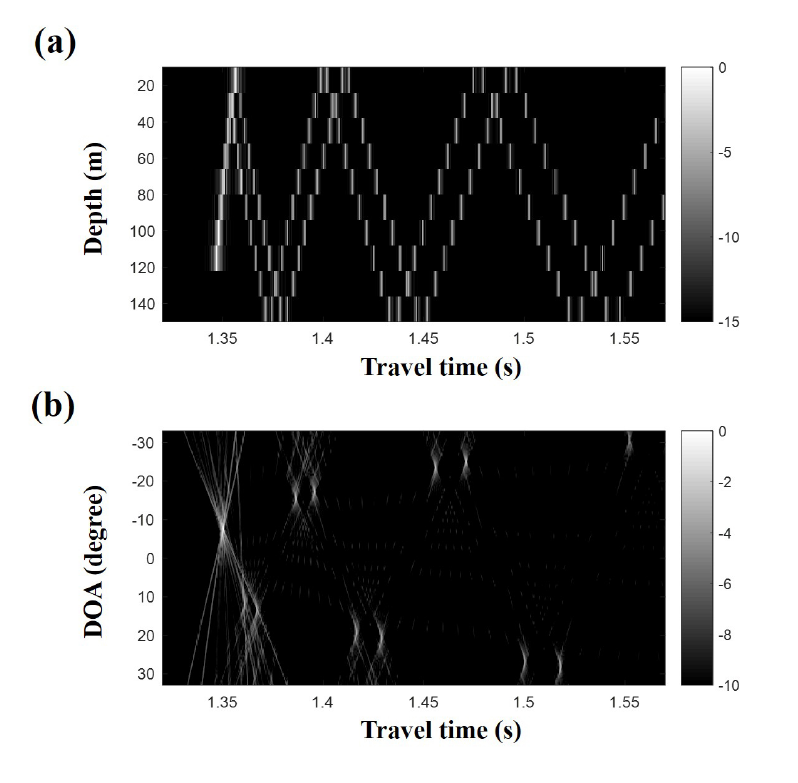
Figure 4. ( a ) simulated arrival structures for the reference sound speed profile and ( b ) their corresponding direction of arrivals, which show high intensities compared to regions around them. The direction of arrivals are estimated using a simple delay-and-sum beamforming with the above arrival